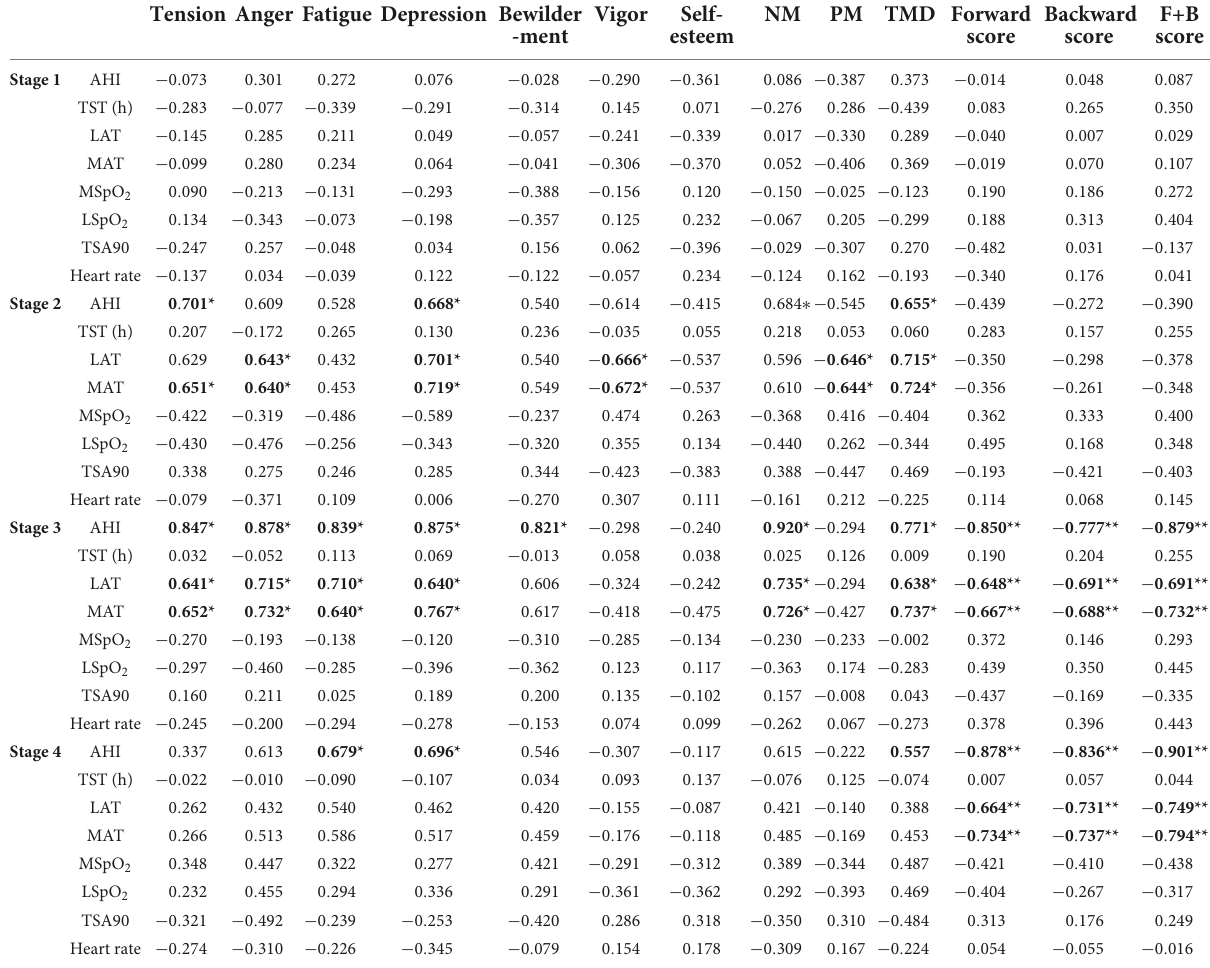
TABLE 2 The association between sleep parameters and short-term memory, and mood states derived from Spearman correlation analysis ( r s ). Tension Anger Fatigue Depression Bewilder